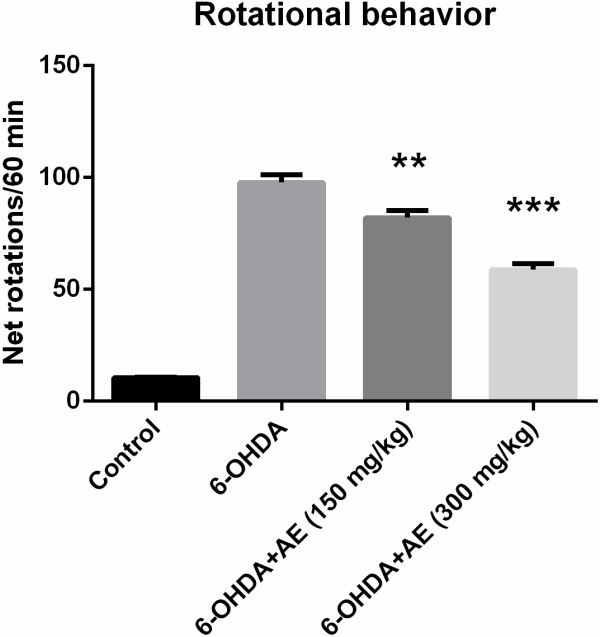
Protective effects of the aqueous extract of A. adianthifolia leaves (150 and 300 mg/kg) on pergolide (0.5 mg/kg, b.w., s.c.)-induced rotational behavior in 6-OHDA-lesioned rats. 1 week after 6-OHDA injection, the number of net rotation contralateral to the lesion side was increased. However, the administration of the aqueous extract of A. adianthifolia leaves restored the decrease in the number of net rotation. Values are means ± S.E.M. (n = 10 animals per group), **p < 0.001, ***p < 0.0001 vs. 6-OHDA alone treated-group.